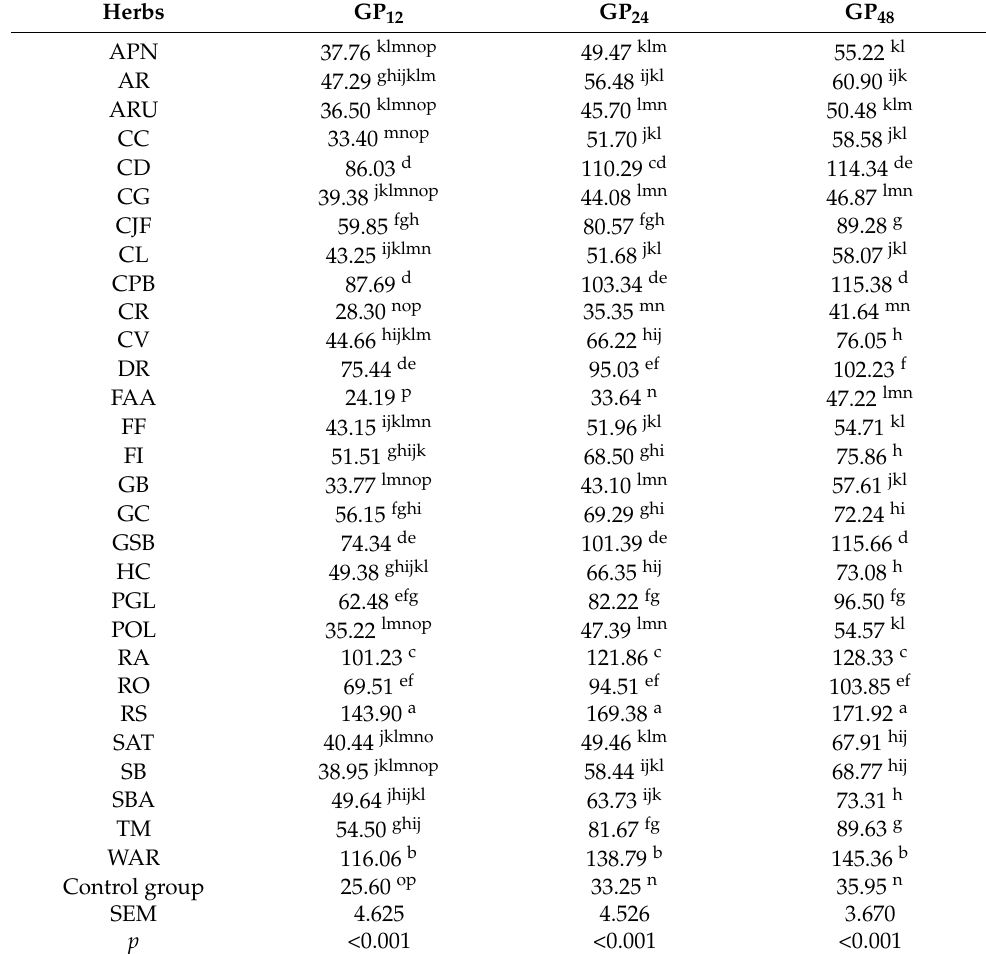
Table 5. Gas production of 29 different Chinese herbs at 12, 24, and 48 h of in vitro incubation. Herbs